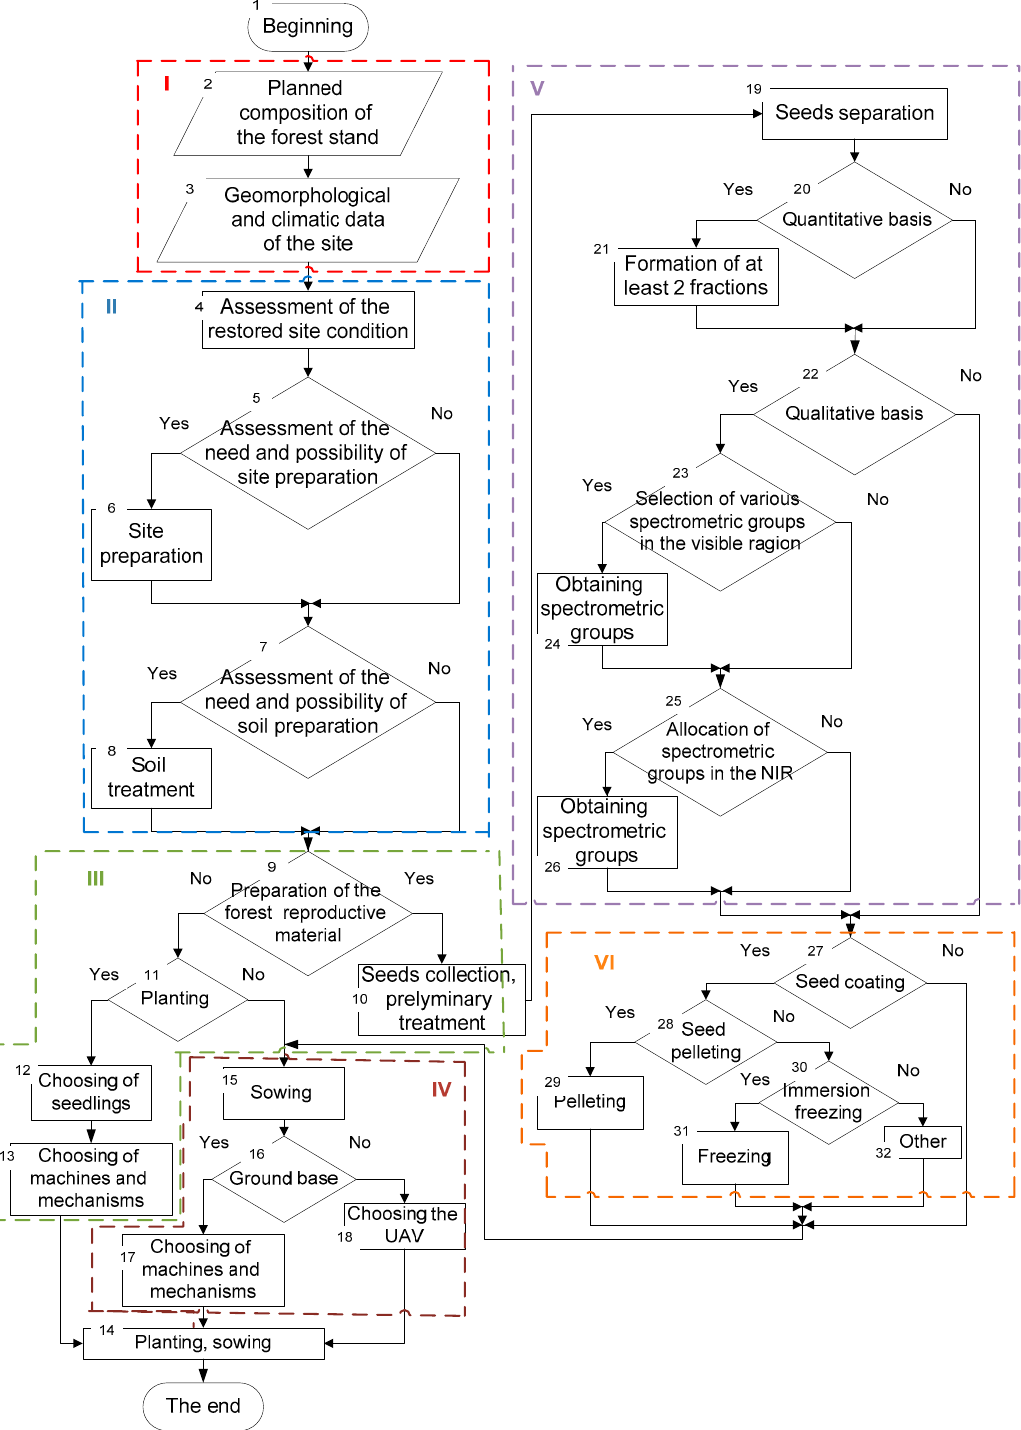
Figure 3. The developed algorithm that takes into account current trends in FLR technology.